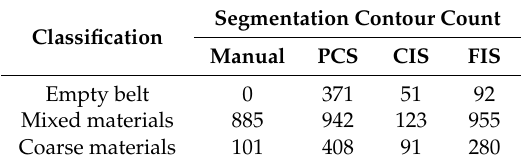
Table 1. The segmentation contour count of various algorithms.